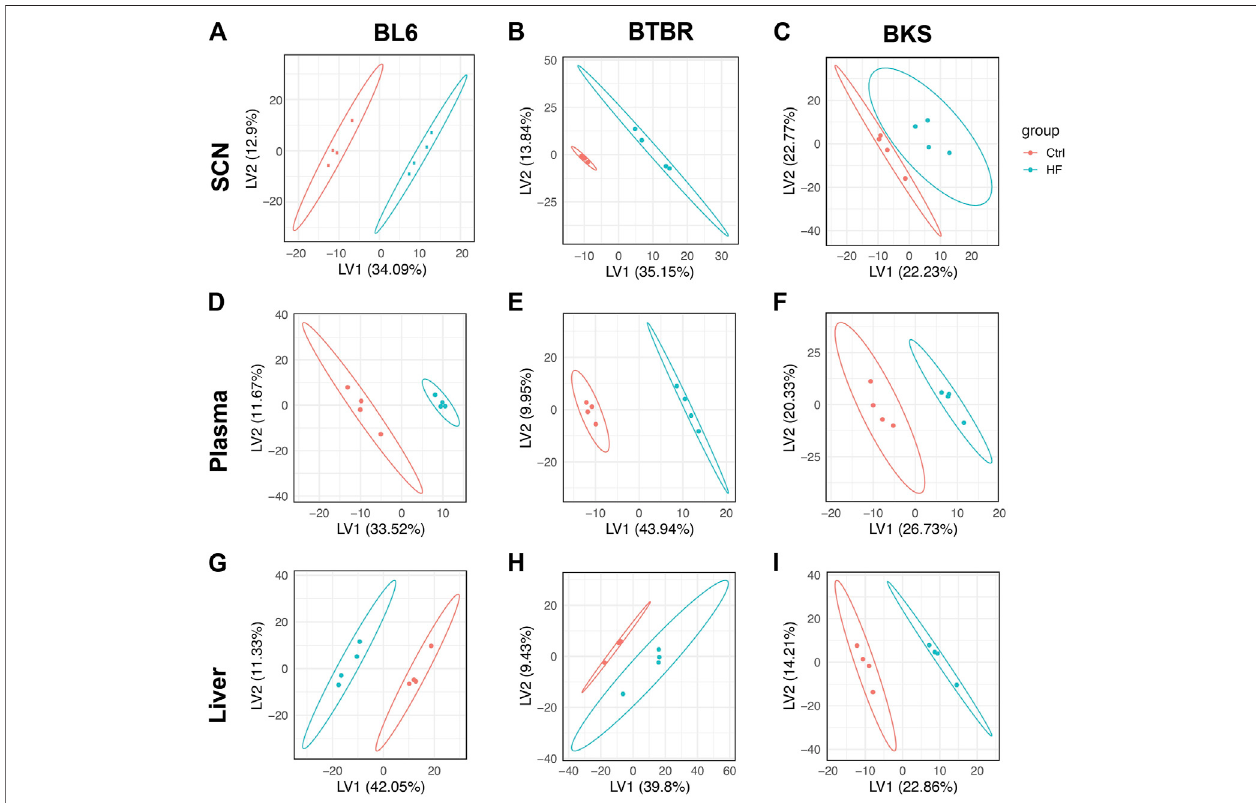
FIGURE 2| Score plots of lipid changes across species. Partial least squares-discriminant analysis (PLS-DA) showed strain-dependent separation oflipid species betweentheSD(red)andHFDmice(blue);dotsrepresentindividualmice.BL6micewithweightgain,dyslipidemia,andbothlarge fi berandsmall fi berPN (A) andBTBR micewithweightgainandlarge- fi berPN (B) showeddistinctseparationofsciaticnerve(SCN)lipidsbetweenSDandHFDgroupscomparedtoBKSmicewithlarge fi ber PN without weight gain (C) . Whereas, clear separation between plasma (D – F) and liver lipids (G – I) was visible across murine strains.